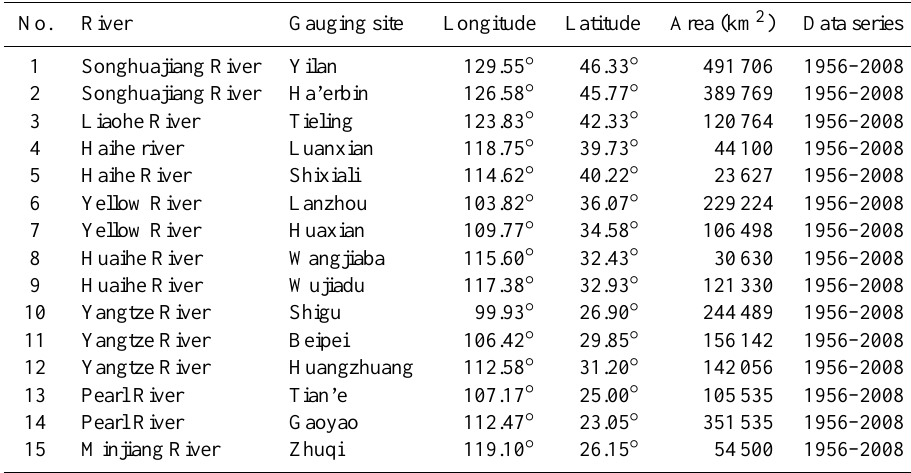
Table 1. River basins used to test model performance.